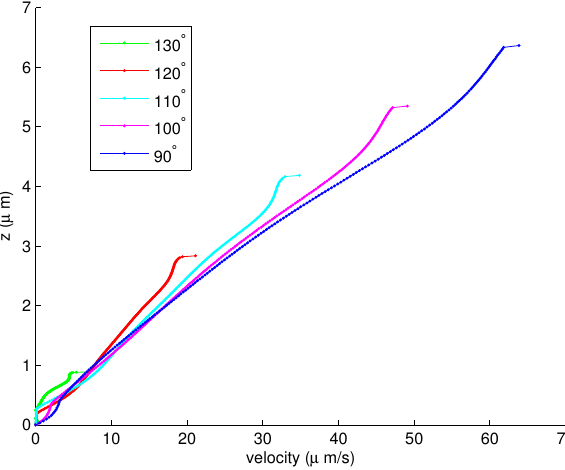
Figure 6. The velocities of the PCL fluid for the angles θ = 130 ◦ to θ = 90 ◦